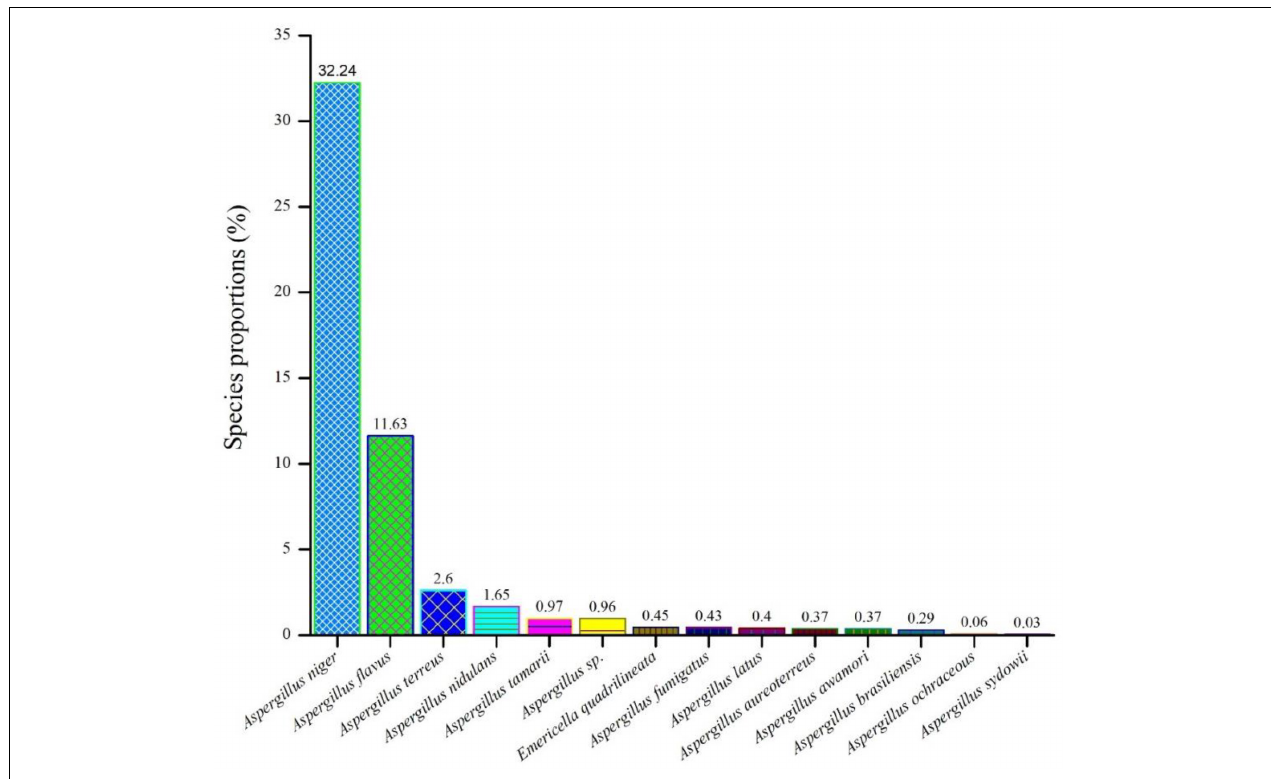
FIGURE 1 | An assessment of the relative abundances of several Aspergillus species in the F . vulgare samples.